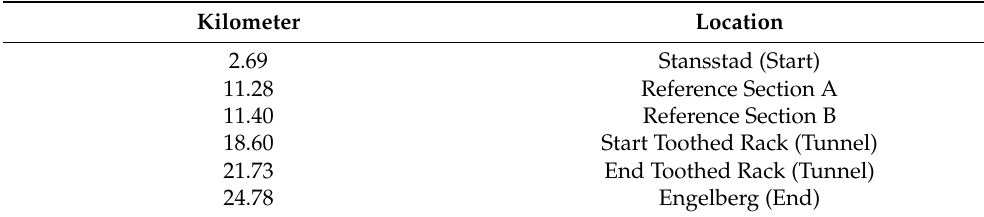
Table 1. Listing of the route for the measurements, including the reference sections and the toothed rack section inside the